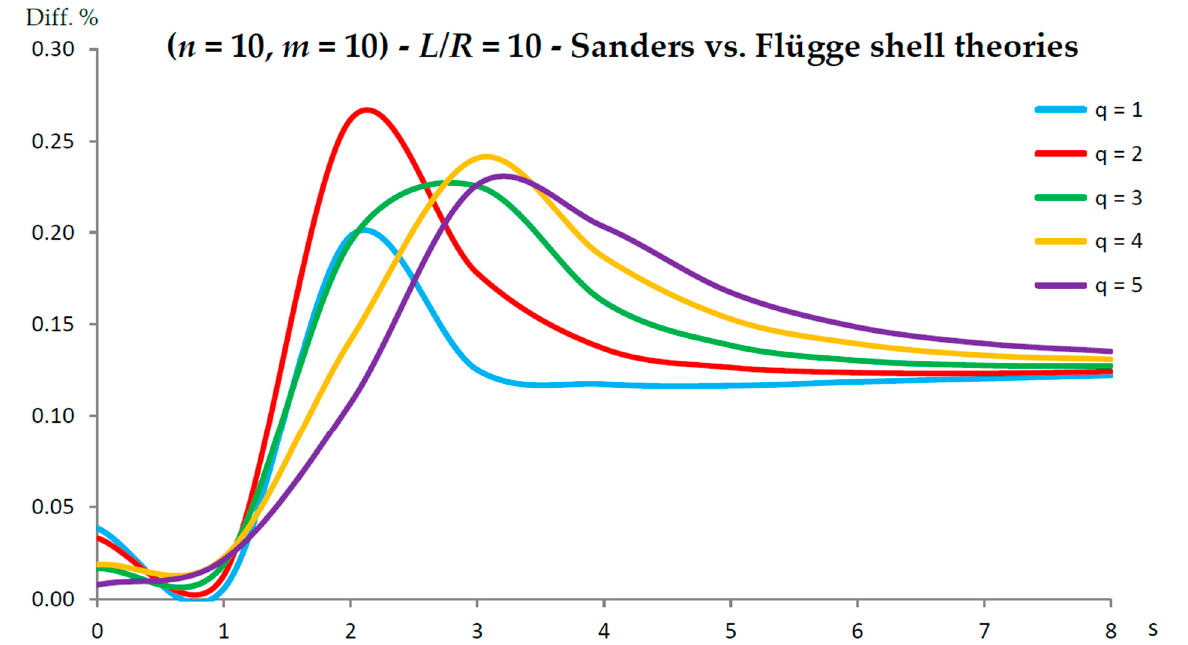
Figure 5. Percentage differences between the radial natural frequencies obtained via Sanders and Flügge shell theories (Flügge as the reference). Anisotropic elastic shell model. Simply supported SWCNT of Table 1 with chirality indices ( n = 10, m = 10 ) and aspect ratio L / R = 10. Number of longitudinal half-waves q . Number of circumferential waves s .